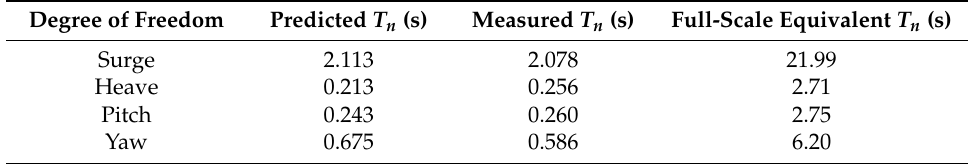
Table 7. Comparison between theoretical and obtained natural periods, with full-scale equivalent values. Degree of Freedom Predicted T n